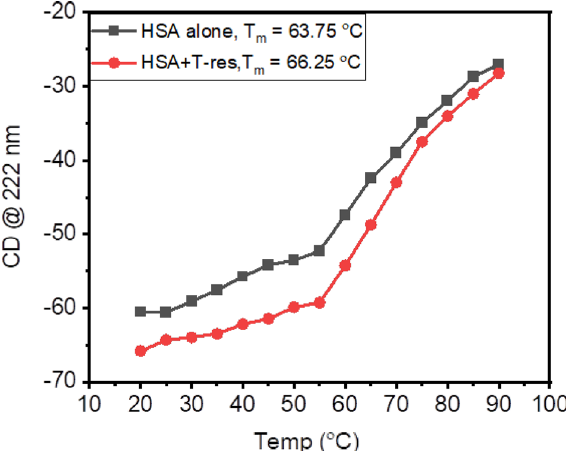
Figure 6. Thermal melting profile of HSA (5 µM), in the presence of trans -resveratrol (20 µM) for the calculation of T m at the temperature range of 20 °C to 90 °C and pH